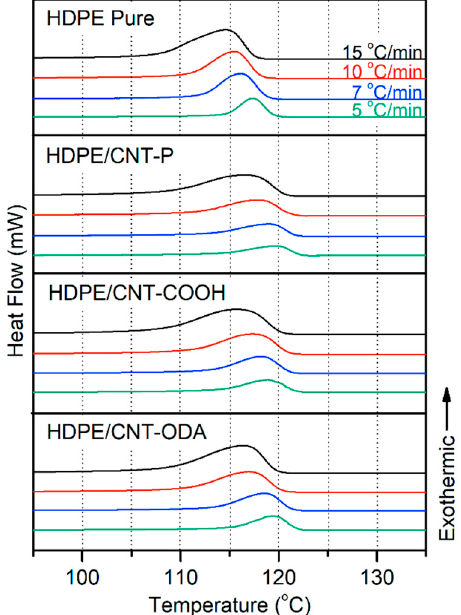
Figure 2. Differential scanning calorimetry (DSC) cooling curves at various cooling rates (5, 7, 10, and 15 °C/min) for pure high-density polyethylene (HDPE) and high-density polyethylene carbon nanotubes (HDPE/CNT) nanocomposites.